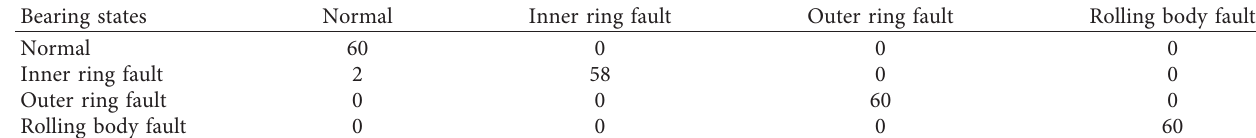
Table 7: Confusion matrix of test results with λ � 0.0001.